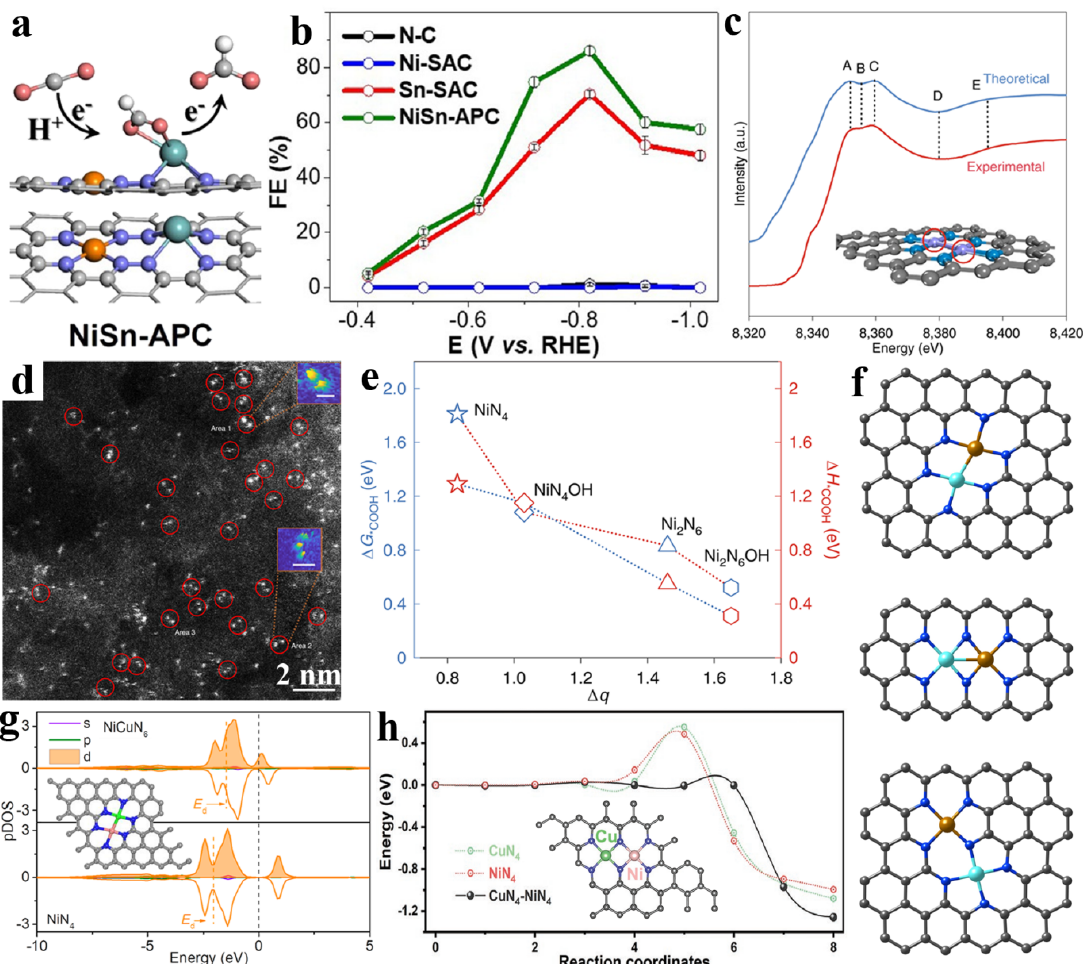
Figure 7. ( a ) Scheme illustration for CO 2 RR of NiSn-APC. ( b ) Faradaic efficiencies for formate. Reprinted with permission from ref. [120]. Copyright: (2020) Wiley-VCH GmbH. ( c ) A comparison between the experimental and the simulated XANES spectra for Ni 2 NC. ( d ) The HAADF-STEM images (inset: the Ni-Ni atoms pair. Area 1, 0.25 nm; area 2, 0.5 nm). ( e ) The relationship between Bader charges (Δq) and Gibbs free energy/Helmholtz free energy for *COOH formation on different sites. Reprinted with permission from ref. [84]. Copyright: (2022) Nature Publishing Group. ( f ) Atomic structure of different dual-metal sites on graphene layer. Reprinted with permission from ref. [122]. Copyright: (2022) Wiley-VCH GmbH. ( g ) Partial density of states (pDOS) of Ni in NiN 4 and NiCuN 6 . Reprinted with permission from ref. [123]. Copyright: (2022) American Chemical Society. ( h ) Climb- ing image nudged elastic band (CI-NEB) calculated kinetic reaction processes. Reprinted with per- mission from ref. [124]. Copyright: (2022) Wiley-VCH GmbH. To date, some works about the neighboring heterometal M 1 M 2 N x sites (M 1 /M 2 : Fe, Co, Ni, Cu, Zn, etc.) catalysts have been published. Li et al. designed several possible bi- metallic site configurations with DFT computational simulations, i.e., non-bridged (Fe- Ni)N 6 , 2N-bridged (Fe-Ni)N 6, and 1N-bridged (Fe-Ni)N 7 sites (Figure 7f). The optimal CO 2 RR activity and selectivity were identified to be at the 2N-bridged (Fe-Ni)N 6 sites, which can account for these two metal sites’ synergistic interaction that could simultane- ously promote the adsorption of *COOH and the desorption of *CO while inhibiting the